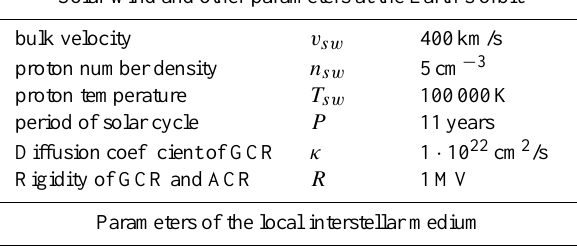
Table 1. The parameter for the calculations, while the interstellar parameters are assumed to be valid at “infinity” Solar wind and other parameters at the Earth’s